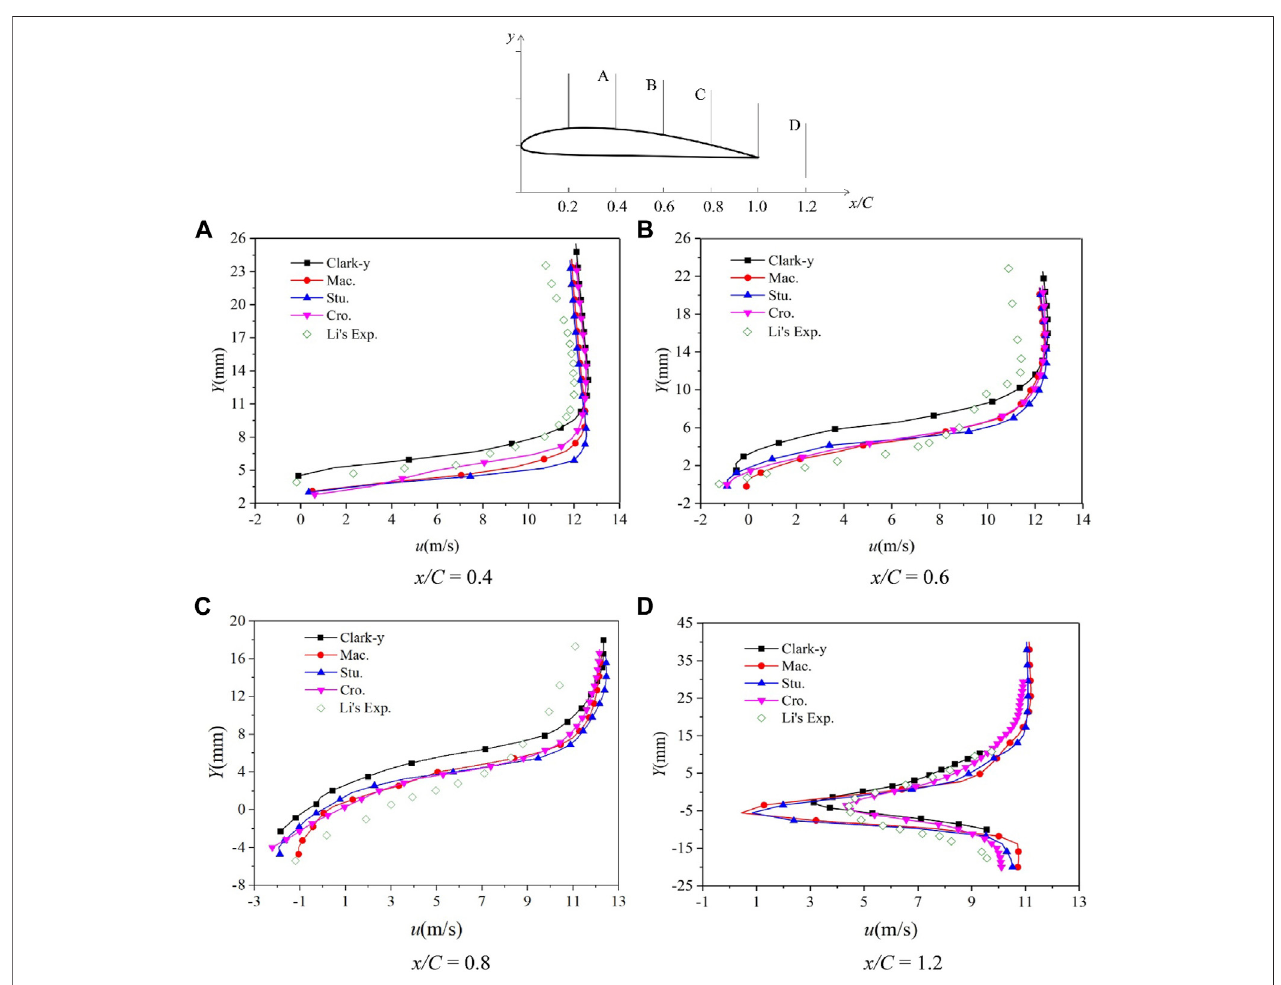
FIGURE 8 | Time-averaged velocity fl uctuation curve along the fl ow direction around the four hydrofoils.